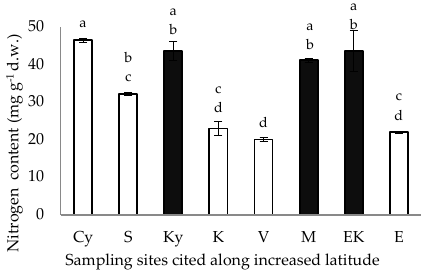
Figure 5. Nitrogen content of the fruit pericarp of C. spinosa harvested from inland (closed bars) and coastal habitats (open bars), cited along increased latitude. The values are means ± standard deviation; significant difference ( p < 0.05) of mean values was detected using Kruskall–Wallis’ test and is marked using lowercase letters, according to post hoc analysis.